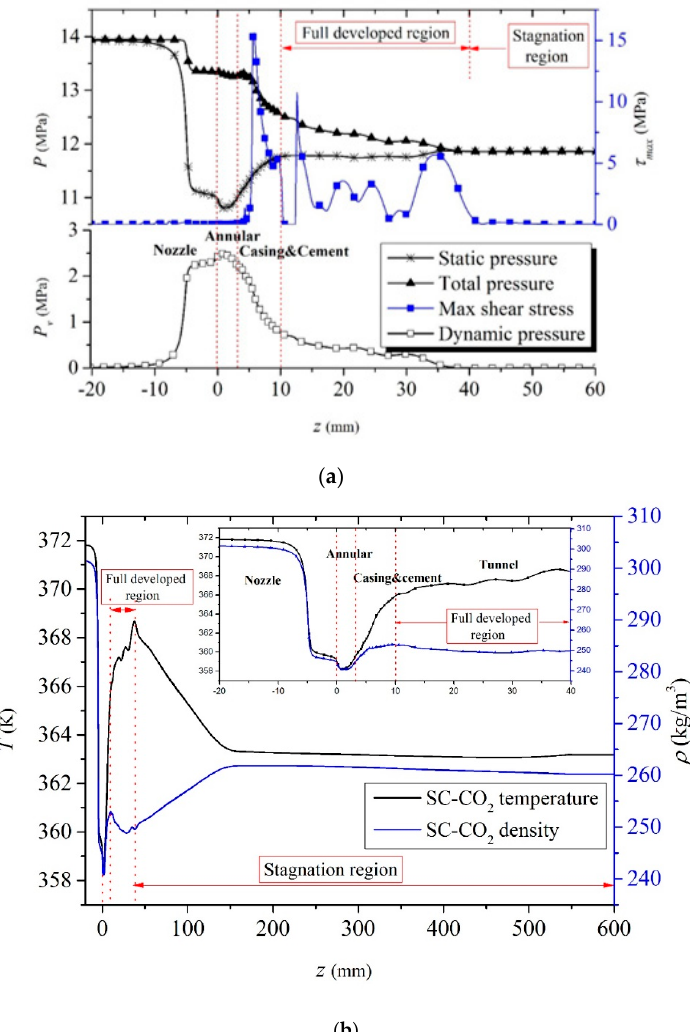
Figure 8. The variation of the dynamical parameters of SC-CO 2 jet along the axial direction. ( a ) Static pressure and dynamic pressure; ( b ) Density and temperature.